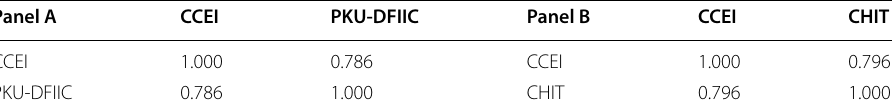
Panel A result is based on annual data from 2013 to 2018. Panel B result is based on monthly data from January 2012 to December 2020